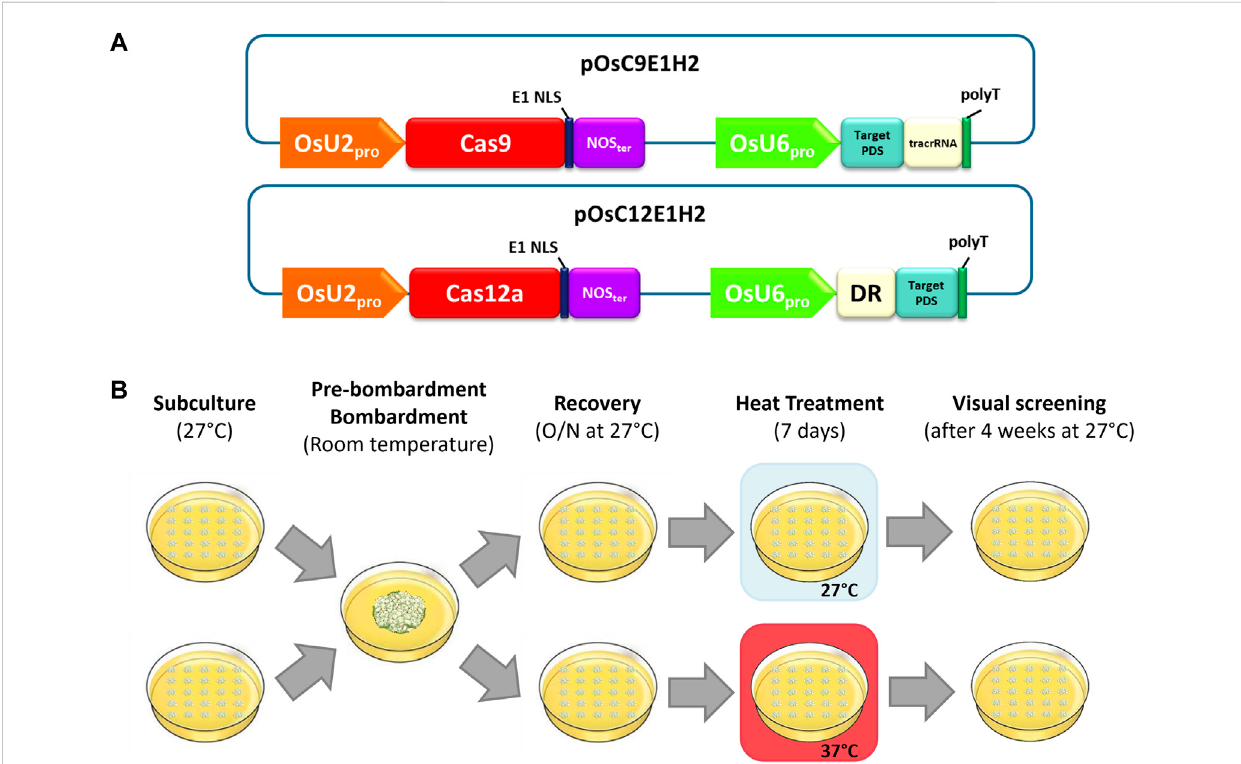
FIGURE 1 Experimental design overview. (A) Schematic representation of the plasmids used for stable biolistic transformation. (B) Work fl ow of temperature treatment for assessing Cas9/Cas12a editing rates.